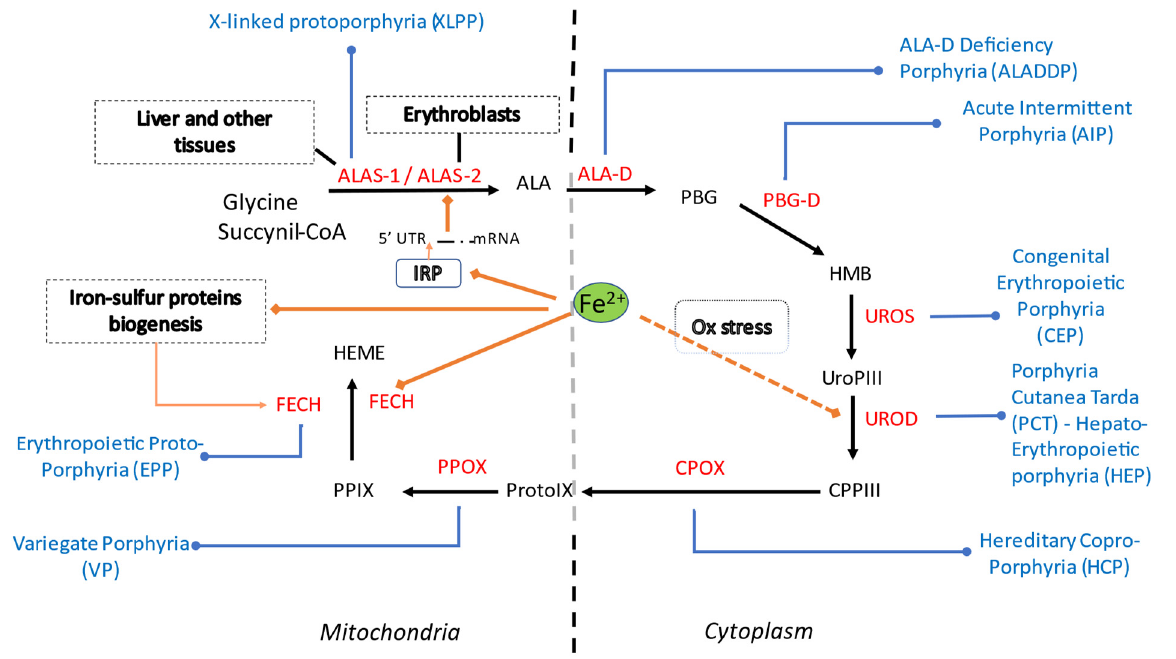
Figure 2. Summary of heme synthetic pathway, types of porphyrias and iron influences within the cell (cytosolic and mitochondrial compartments). Heme synthesis starts in mitochondria, with the condensation of succinyl-CoA with the amino acid glycine, activated by pyridoxal phosphate by ALA synthase, the rate-limiting enzyme of heme synthesis. ALA then enters the cytoplasm, where, in the presence of ALA dehydratase, porphobilinogen and water molecules are formed. Four PBG molecules are joined by PBG deaminase as hydroxymethylbilane. Linear tetrapyrrole cyclizes to form a ring known as uroporphyrinogen III with the participation of uroporphyrinogen III synthase. Through the activity of uroporphyrinogen III decarboxylase (UROD), coproporphyrinogen III is generated. In mitochondria CPG is then transformed into protoporphyrinogen, which is then further oxidized to protoporphyrins. Finally, iron is incorporated to generate heme. In each specific form of porphyria (in blue) the activity of a specific enzyme (in red) in the heme biosynthetic pathway is defective and leads to accumulation of pathway intermediates. Iron (Fe2+) is involved in ALAS2 regulation via the IRE-IRP system, in FECH activity and possibly in UROD activity.